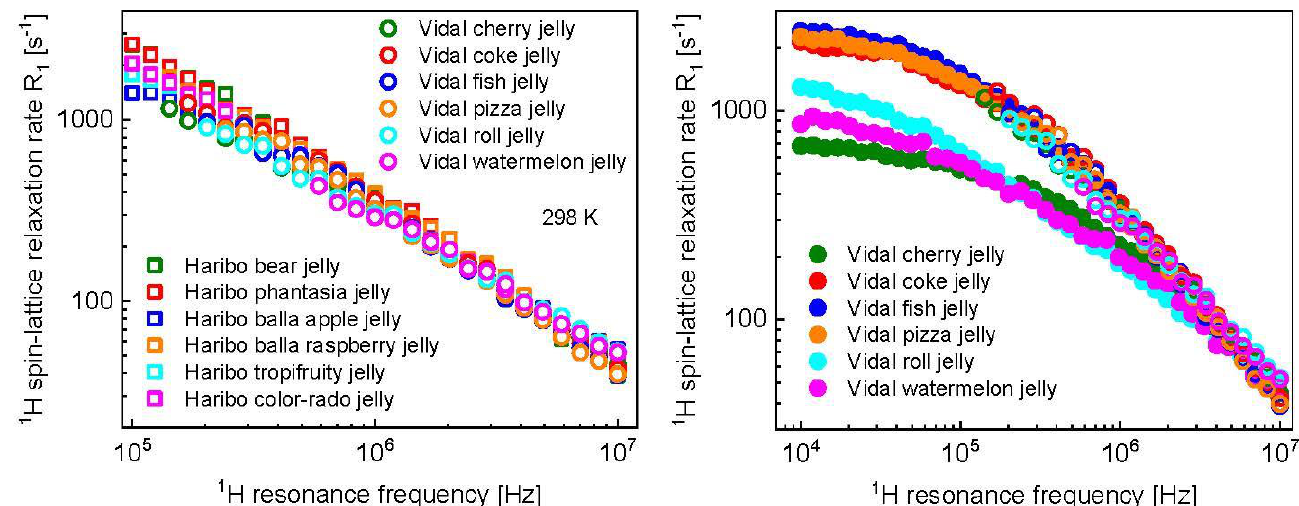
Figure 5. ( left ) 1 H spin-lattice relaxation rates for various kinds of Vidal jelly at 298 K compared with 1 H spin-lattice relaxation rates for various kinds of Haribo jelly at 298 K, ( right ) 1 H spin-lattice relaxation rates for various kinds of Vidal jelly at 298 K (open symbols) and 323 K (solid symbols).